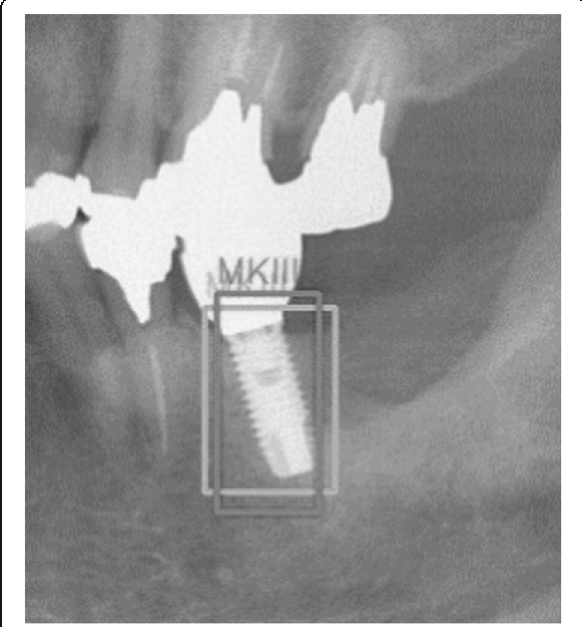
Fig. 1 Sample image for calculating IoU (MK III implant). The light gray square indicates the ground-truth bounding box, and the dark gray square indicates the predicted bounding box. IoU value was calculated that the overlapped area of light gray and dark gray squares was divided by the united area of light gray and dark gray squares